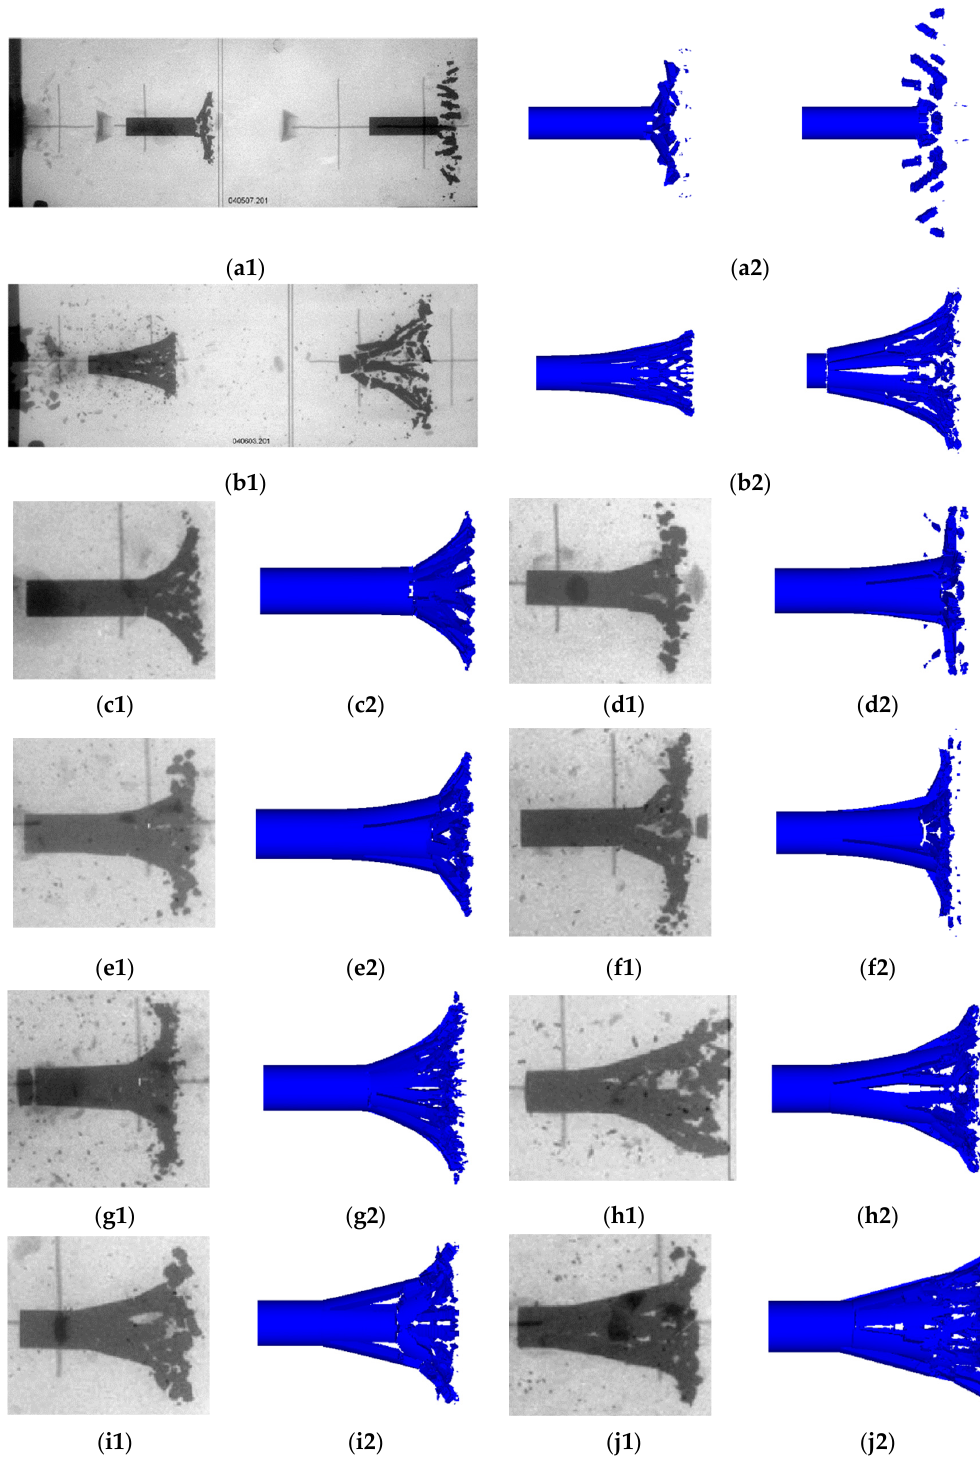
Figure 14. Comparison of test results and simulation results under different conditions: ( a1 ) #1 experiment result; ( a2 ) #1 simulation result; ( b1 ) #8 experiment result; ( b2 ) #8 simulation result; ( c1 ) #2 experiment result; ( c2 ) #2 simulation result; ( d1 ) #3 experiment result; ( d2 ) #3 simulation result; ( e1 ) #4 experiment result; ( e2 ) #4 simulation result; ( f1 ) #5 experiment result; ( f2 ) #5 simulation result; ( g1 )